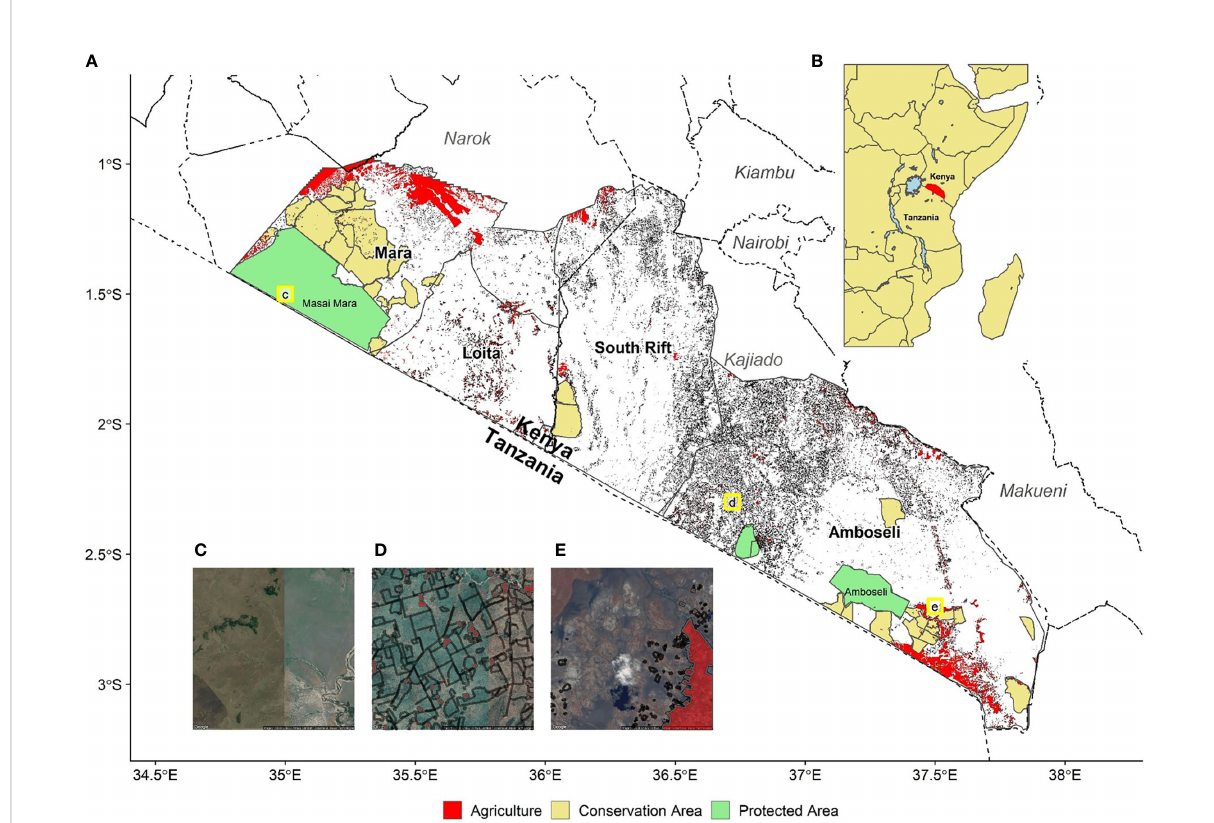
FIGURE 1 (A) ~40,000 km offencing (black) and ~1,500 km 2 of agriculture (red) across four southern Kenya ecosystems (left to right: Maasai Mara; Loita, South Rift Valley, Amboseli). Kenya county boundaries are shown for reference (dashed lines); (B) inset showing the study area (red) within East Africa; (C – E ) zoomed in panels of three areas under different states of fencing and agricultural development, with Google Maps imagery for